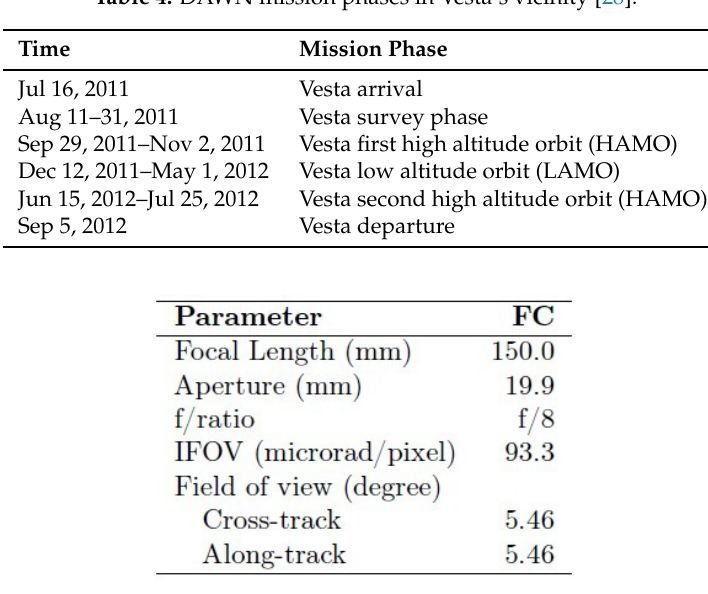
Table 4. DAWN mission phases in Vesta’s vicinity [28].